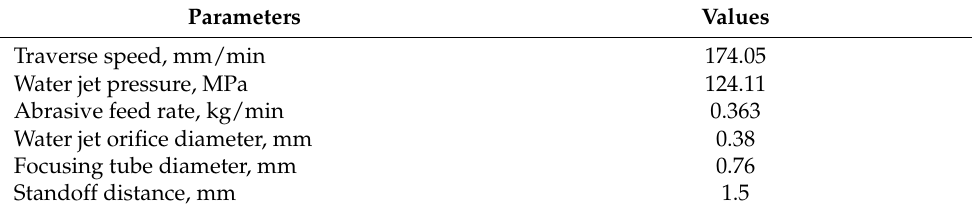
Table 3. Process parameters.